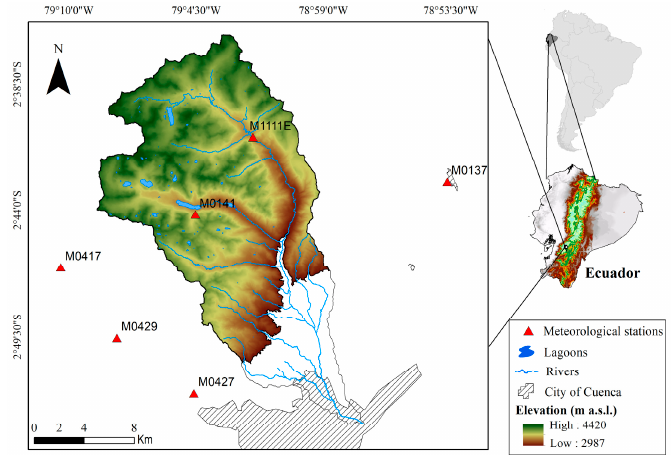
Figure 1. Location of the Machángara river subbasin and the meteorological stations.